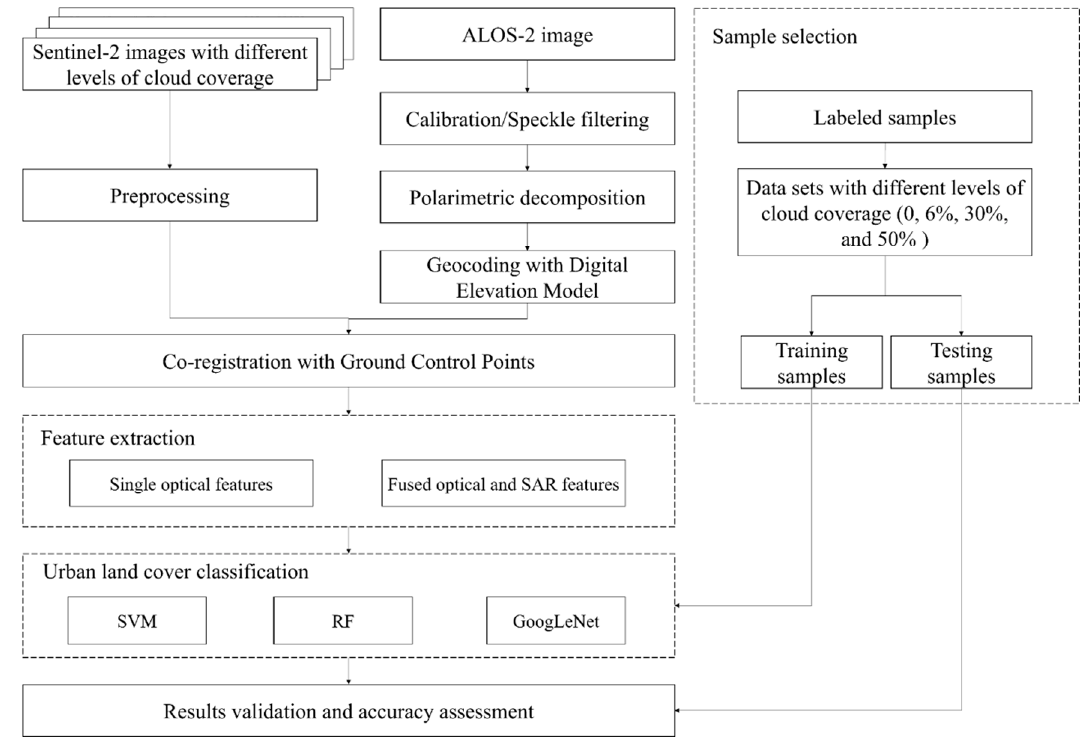
Figure 2. The methodological framework of this study.